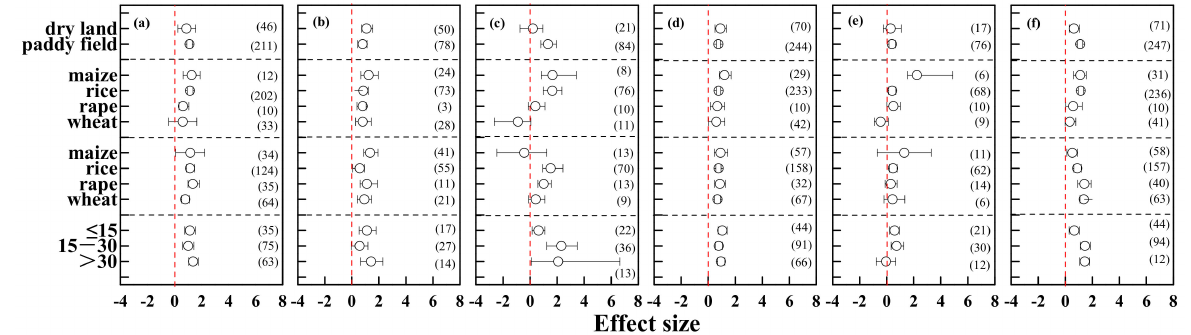
Figure 4. Effects of SDMI application on soil total N ( a ), available N ( b ), total P ( c ), available P ( d ), total K ( e ), and available K ( f ) under different agricultural management practices, expressed as the mean effect size with bootstrapped 95% confidence intervals. The number of observations for each category is given in parentheses. The differences between categories are significant if the probability level ( p ) is <0.05. The overall effect size is significantly positive or negative if 95% confidence interval does not overlap with zero at p = 0.05 level, and the difference in effect size between two categories is significant if 95% confidence intervals in the categories are not